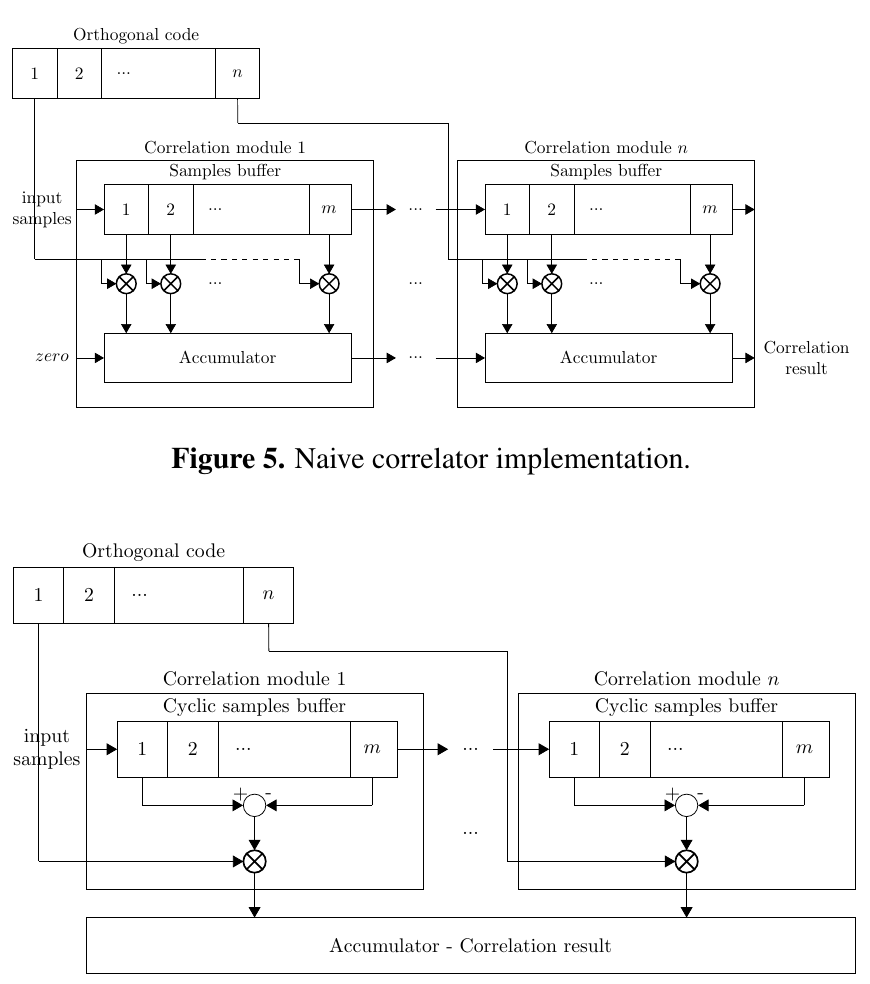
Figure 6. Optimized correlator implementation.